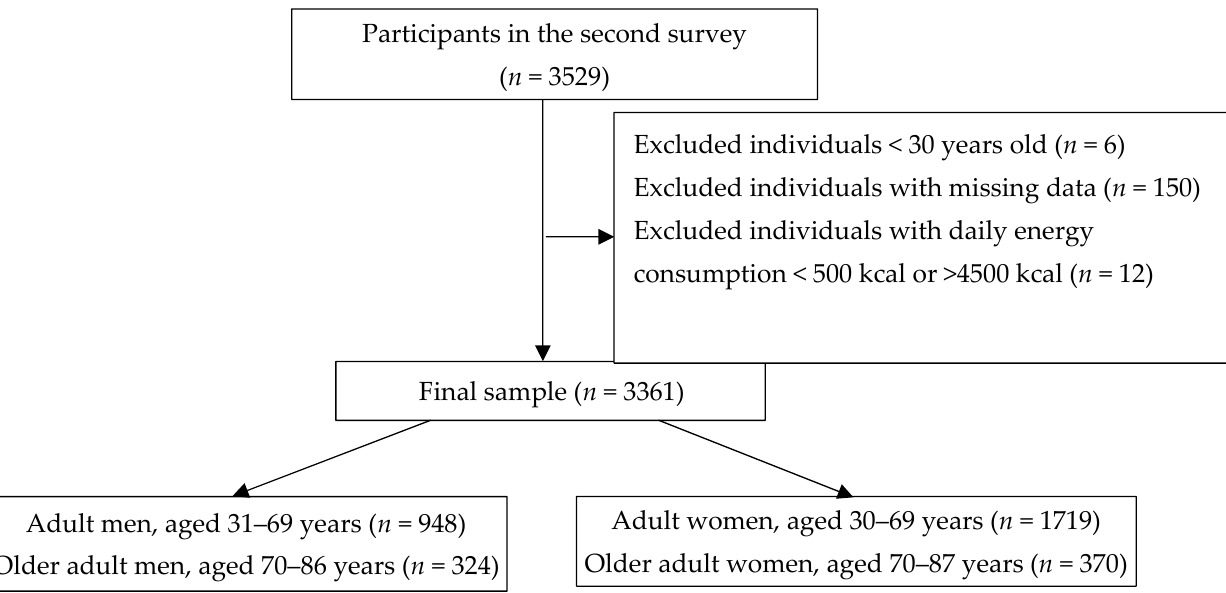
Figure 1. Flow chart of participant selection.